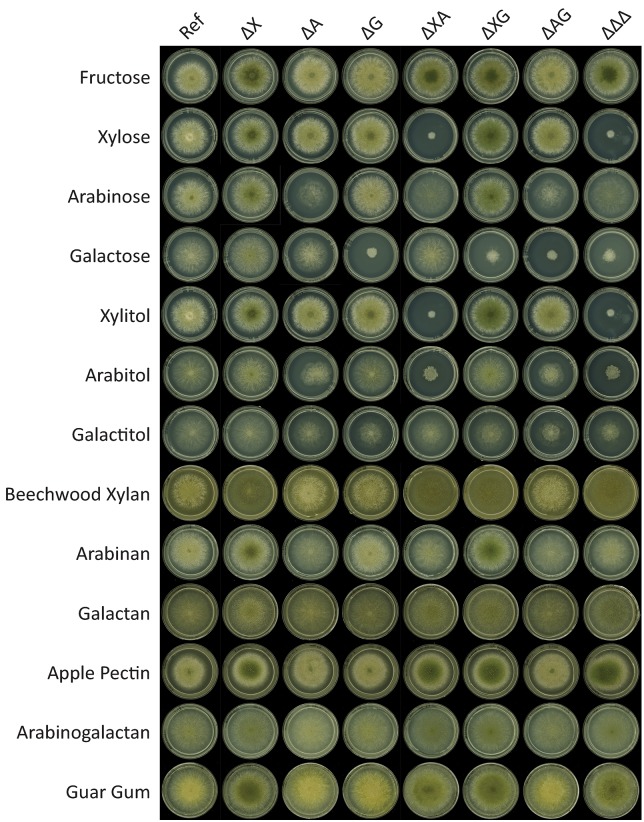
Growth profiling of an A. nidulans reference strain and single, double and triple disruptants of araR, xlnR, and galR on medium containing different carbon sources.Strain codes are described in Table 1. Strains were grown for 3 days at 37°C.